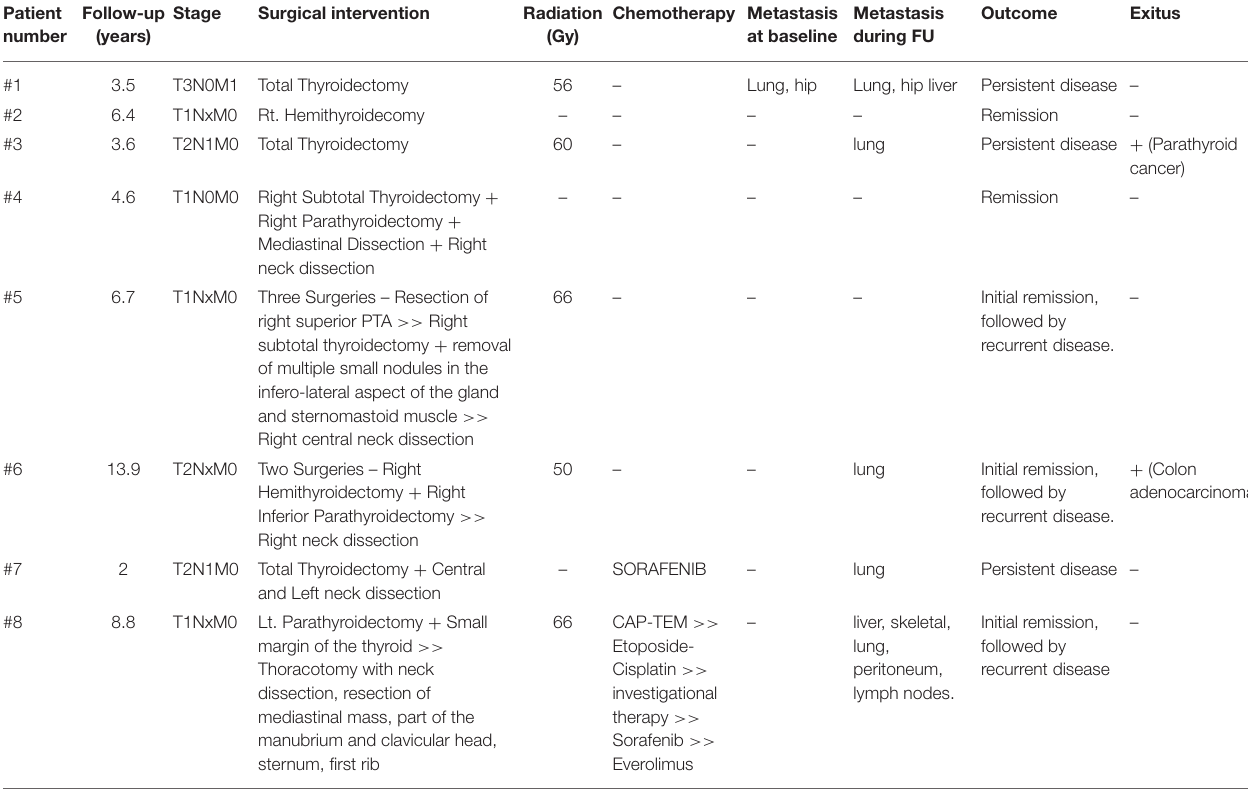
TABLE 1 | Clinical data and therapeutic approaches for eight patients with parathyroid carcinoma. Patient Follow-up number (years)